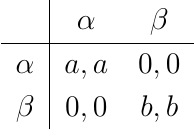
Table 3. A general two-person, two-strategies pure coordination